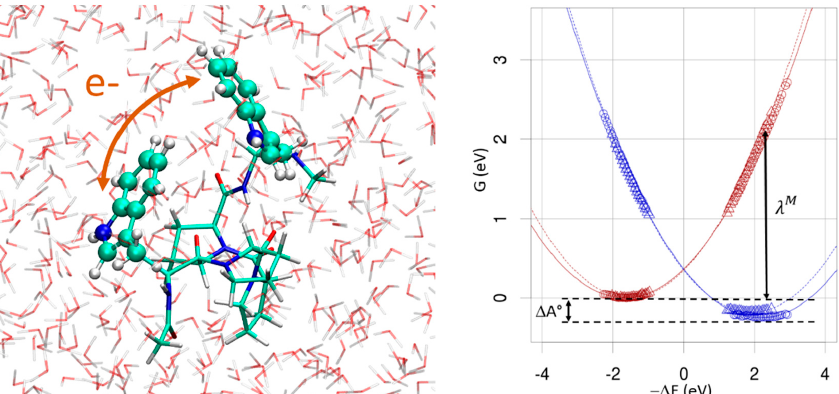
Figure 11. Constrained DFT / MM simulation of charge transfer between tryptophane residues. Left: zoom on the peptide. The atoms with ball-and-stick representation are treated at the QM level. All other atoms are treated with force field (FF). Right: Marcus theory free energy profiles taking the vertical energy gap as reaction coordinate. Circles and triangles correspond to simulation data obtained from non-polarizable and polarizable FF respectively. The lines correspond to parabolic regressions on the simulation data (with induction in dashed lines, without induction in plain lines). The points at the bottom of each free energy curves are directly coming from the simulation data while those are obtained by applying ∆ G ( ε ) = ε which derives from the ergodic hypothesis (see Reference [102] for demonstration).